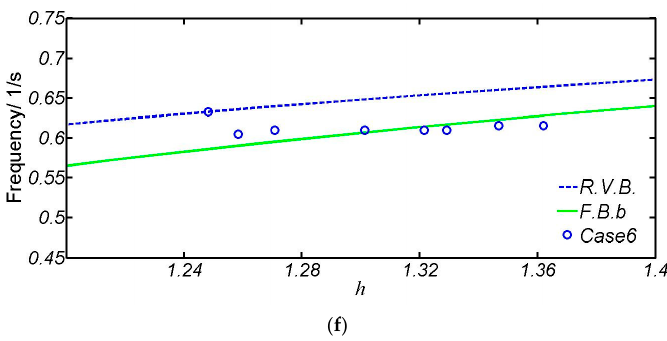
Figure 10. Prediction results with consideration of the free surface velocity and width of the weir. ( a ) Case 1; ( b ) Case 2; ( c ) Case 3; ( d ) Case 4; ( e ) Case 5; ( f ) Case 6.